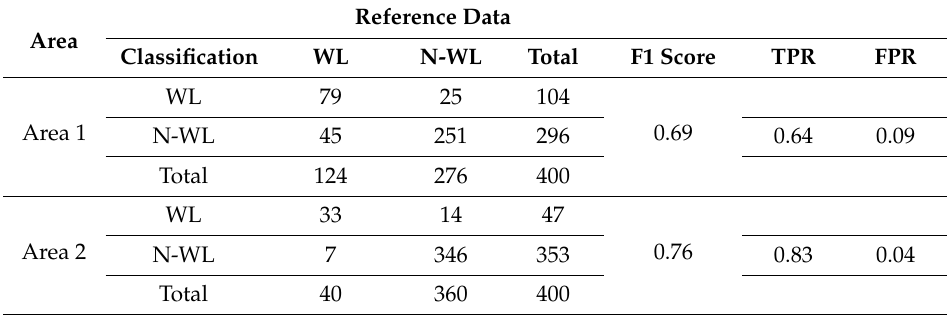
Table 1. Confusion matrices and F1-score for the classification of wild leek in Area 1 and Area